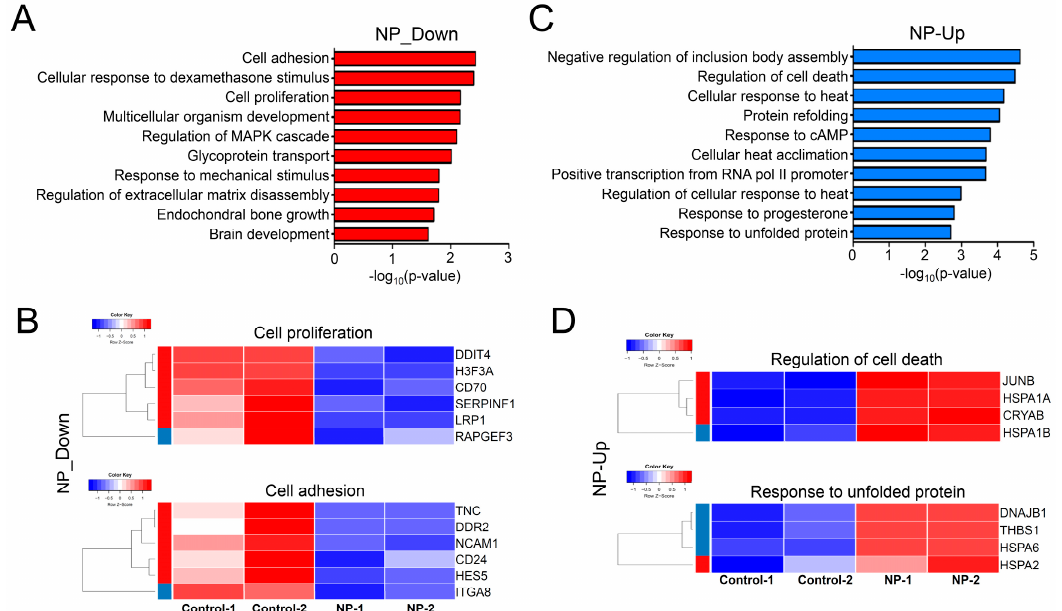
Figure 9. Analysis of gene ontology for the down- or upregulated genes. ( A ) Bar graphs displaying the top 10 GO terms in the genes repressed by graphene oxide. The x -axis scale represents -log 10 ( p -values) values. ( B ) Heatmaps showing the expression of genes in the GO terms of cell proliferation and cell adhesion. NP, nanoparticle. ( C ) Bar graphs displaying the top 10 GO terms in the genes enhanced by graphene oxide. ( D ) Heatmaps showing the expression of genes in the GO terms of regulation of cell death and response to unfolded protein.